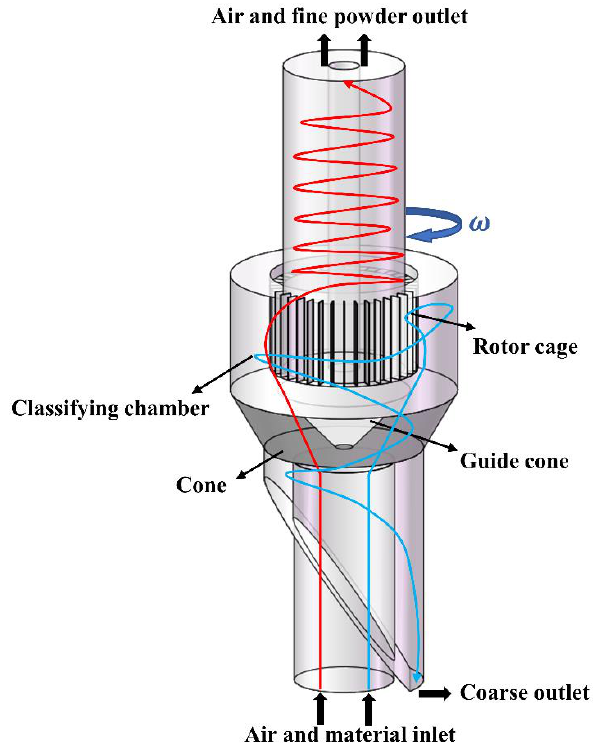
Figure 2. Working principle of the high-efficiency rotor